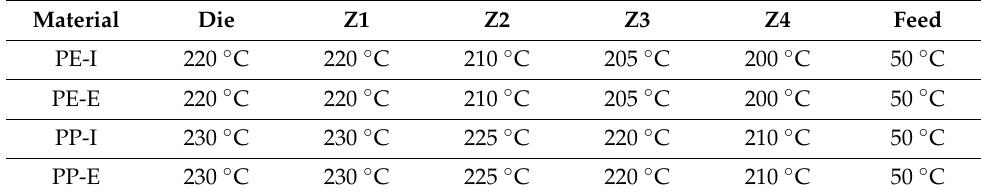
Table 3. Temperature program for the injection molding machine.